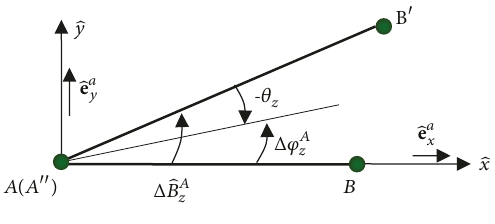
Figure 6: Bending angle of node A.